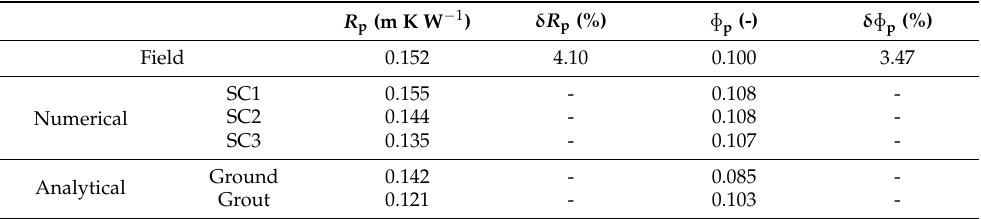
Figure 11. Numerical results (SC1, SC2, SC3) compared to the observations (obs) and the analytical synthetic case based on subsurface input parameters. Table 9. Comparison of oscillation parameters obtained from the analysis of field tests and numerical simulations. The two reference cases calculated with ground and grout properties are also reported.